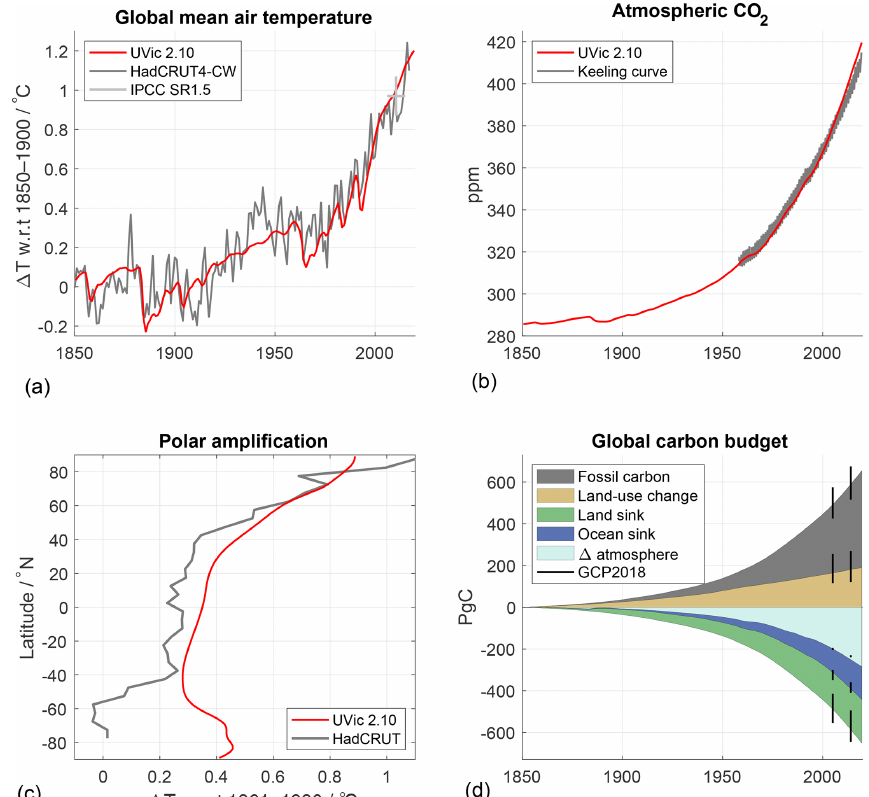
Figure 2. (a) Global mean air temperature change for the UVic ESCM 2.10 relative to 1850–1900 (red line) in comparison with the average observed warming using the filled-in HadCRUT4-CW dataset from Haustein et al. (2017) (grey line) and the IPCC’s special report on 1.5 ◦ C GSAT temperature change for 2006–2015 (light grey cross). (b) Atmospheric CO 2 concentrations in the UVic ESCM 2.10 (red line) in comparison with the Keeling curve from the Mauna Loa observatory (Keeling et al., 2005; grey line). (c) Zonal means of temperature change of the HadCRUT median near-surface temperature anomaly (grey line) (Morice et al., 2012) in comparison to the UVic ESCM 2.10. All temperature changes are for a 30-year mean around 1995 with respect to the 1961–1990 period (in K). (d) The global carbon budget for the UVic ESCM 2.10 partitioned into fossil fuel carbon, land-use carbon emissions, and atmosphere, land, and ocean sinks, compared to cumulative carbon fluxes between 1850 and 2005 and 1850 and 2015 from the Global Carbon Project 2018 (grey lines) (Le Quéré et al.,